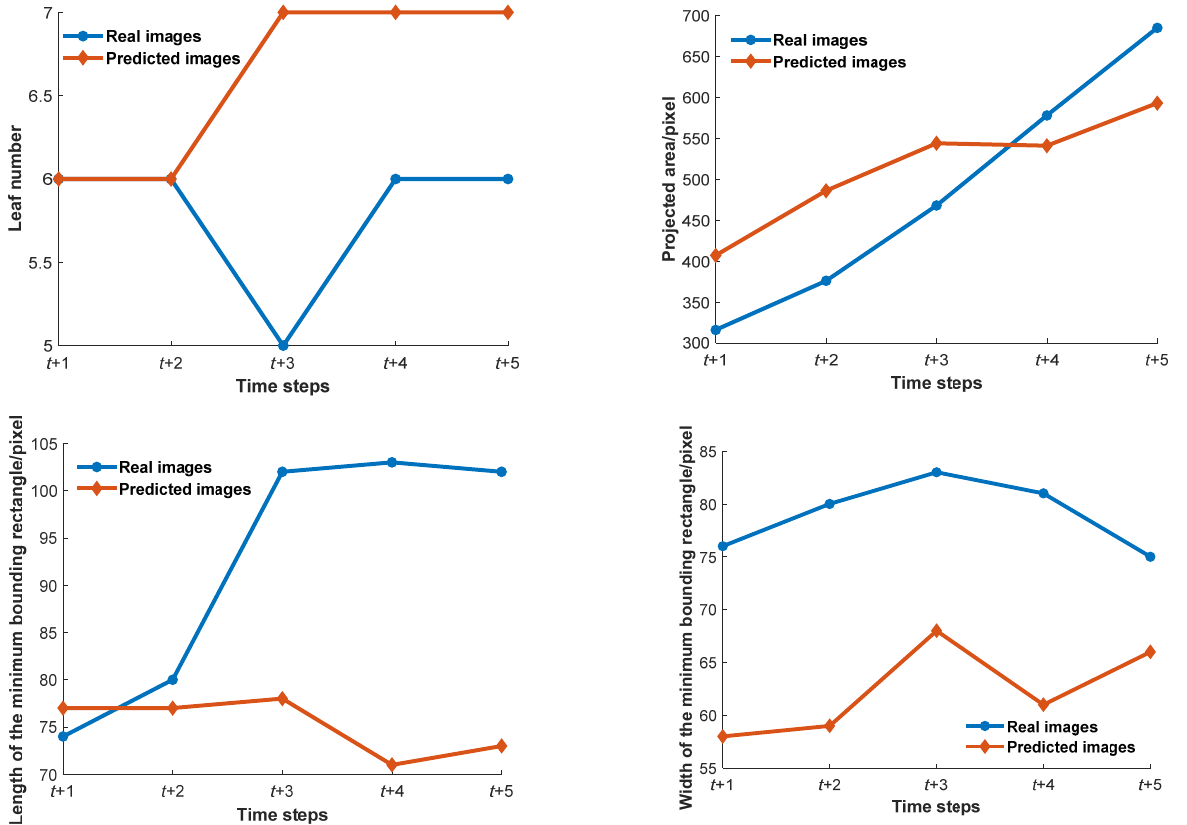
Figure 11. Comparison of leaf number, projected area, and length and width of the minimum bounding rectangle between the predicted and real images of the experimental results on the Panicoid Phenomap-1